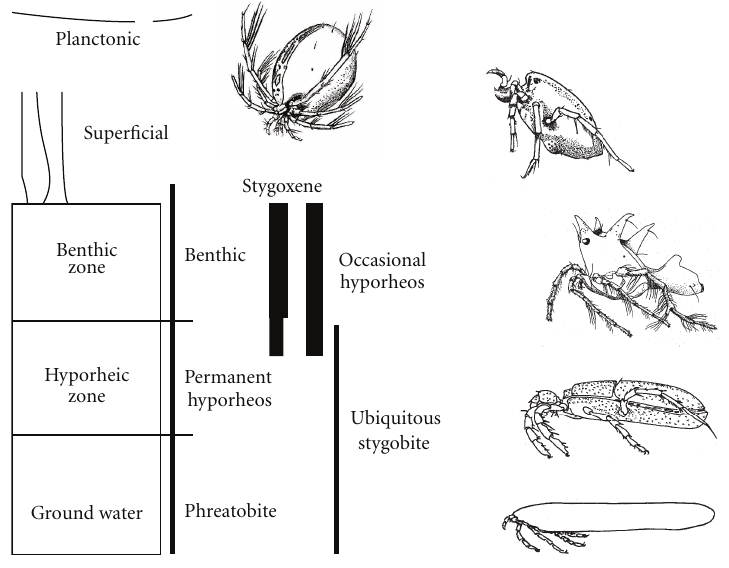
Figure 1: Recognized habitats in aquatic systems (mainly running water) for Hydrachnidia. The vertical lines represent the classification ranges; their width is in proportion with the number of taxa. The forms presented are, from top to bottom: Oxus sp. (Oxidae, planktonic, modified from Barr, 1973), Koenikea sp. (Unionicolidae, superficial, drawn from a photograph by Smith, Cook and Smith, 2001), Arrenurus diabolus Lundblad (Arrenurida, benthic, drawing by B. Rosso de Ferrad´as), Neomamersa falcipalpis Cook (Limnesiidae, ubiquitous stygobite, drawing by H. R. Fern´andez), and Wandesia andiana Cook (Hydryphantidae, phreatobite, drawing by H. R. Fern´andez).